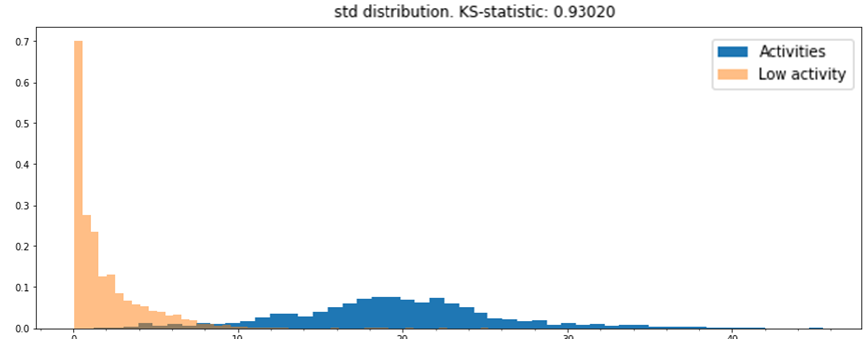
Figure 14. Standard deviation distribution of low- and high-activity windows. Both distributions can be separated using a threshold value.